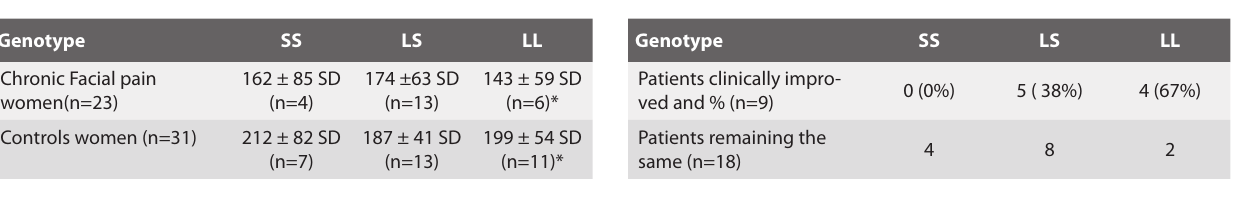
Table 6 compared mean blood serotonin level in the three geno- types of patients and controls. Chronic facial pain patients of all genotypes had a lower blood serotonin compared to controls.